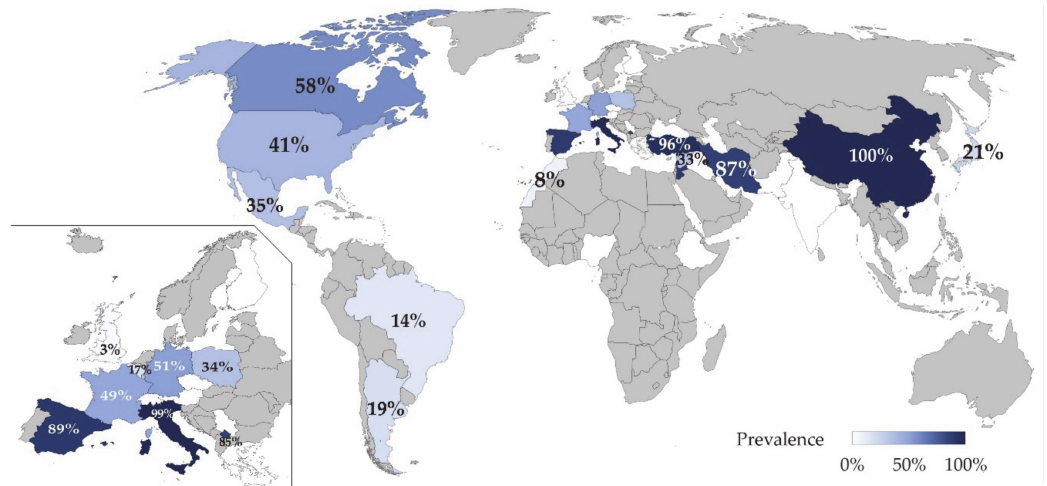
Figure 3. Flock prevalence (%) of SRLV in sheep by country. Data extracted from scientific literature published from 1981 to 2020 and detailed in Table 3. Inset: Higher magnification of Europe.